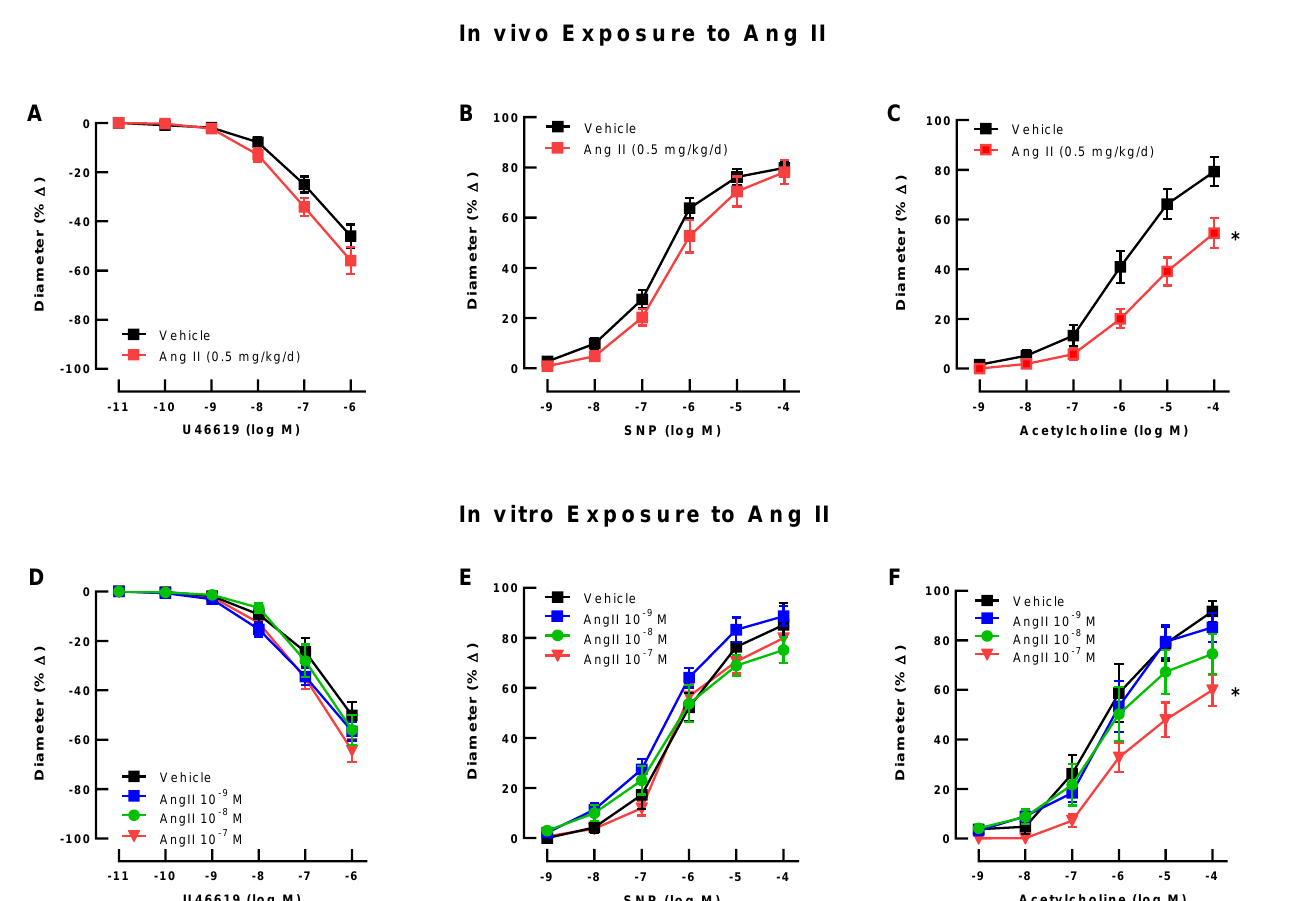
Figure 1. In vivo exposure to Ang II (0.5 mg/kg daily for 7 days) did not affect the response of ophthalmic arteries to the vasoconstrictor, U46619 ( A ), or to the endothelium-independent vasodilator, SNP ( B ), whereas it did cause a substantial degree of endothelial dysfunction (impaired acetylcholine response, ( C )). Values are expressed as mean ± SE ( n = 8 per group; * p < 0.05, Ang II 0.5 mg/kg/d versus vehicle control). In vitro exposure of ophthalmic arteries to different concentrations of Ang II also had no effect on the response to U46619 ( D ) or SNP ( E ), but markedly blunted reactivity to acetylcholine at 10 − 7 M of Ang II ( F ), indicative of endothelial dysfunction. Values are expressed as mean ± SE ( n = 8 per group; * p < 0.05, Ang 10 − 7 M versus vehicle control).